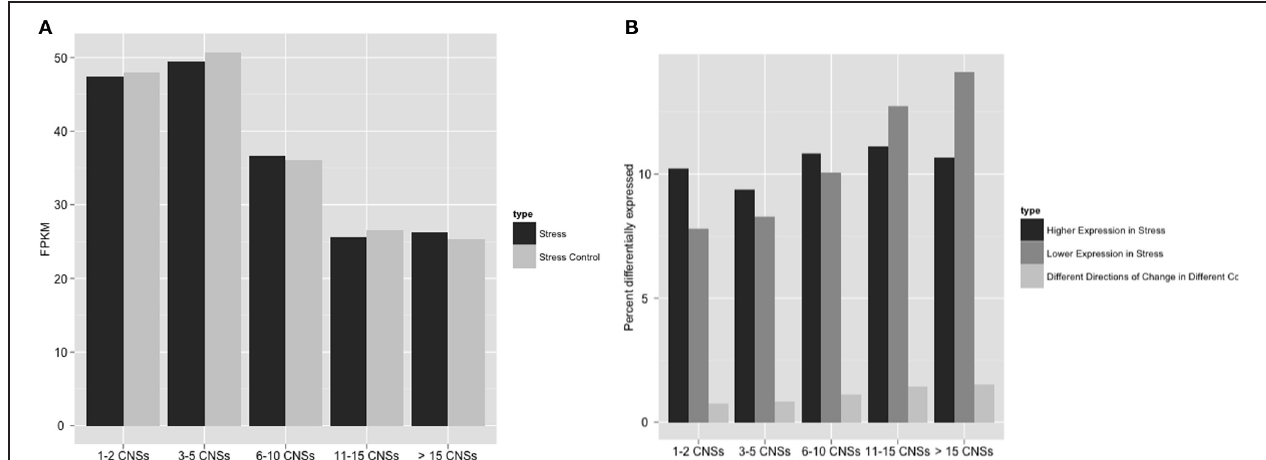
FIGURE 4 | Number of Os-Sb CNSs and association with both raw expression levels and differential expression in sorghum. Panel (A) compares the average raw expression values for stress and stress control to CNS richness of genes. “Stress” here are FPKMs in response to PEG + ABA treatment (Dugas et al., 2011). (B) Differentially expressed categories, as